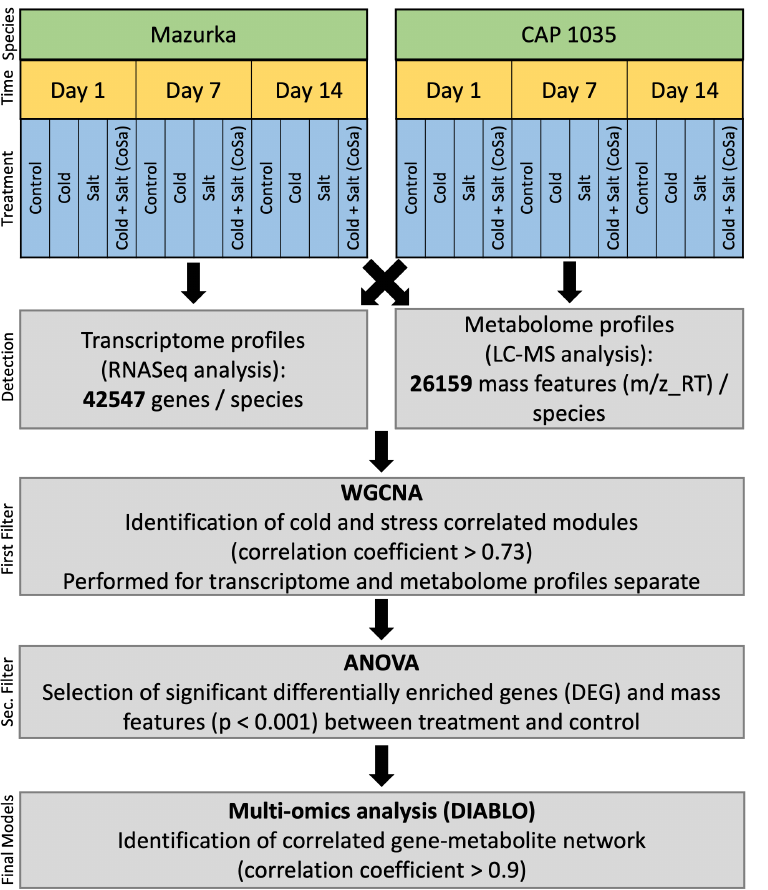
Figure 1. Workflow to explain the experimental design and pipeline that was used to detect key genes and metabolites related to abiotic stress.